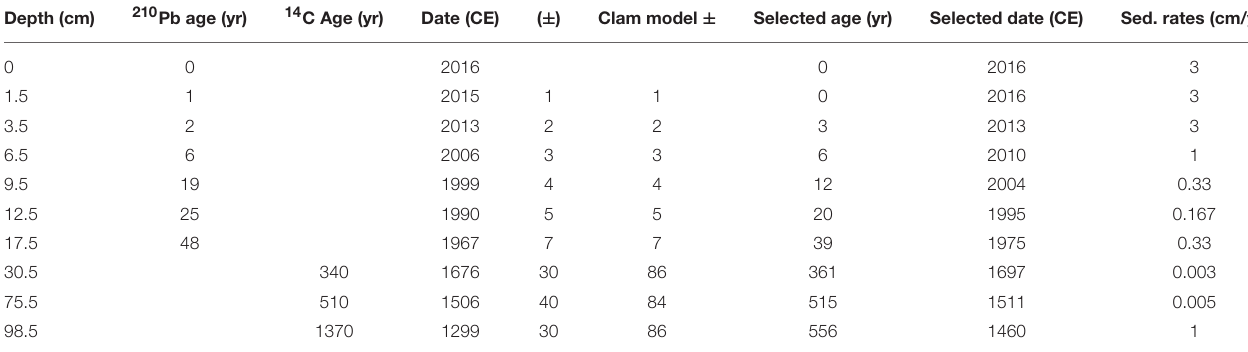
TABLE 2 | Chronology of the dated depth profiles of core LFUQ-M1. Depth